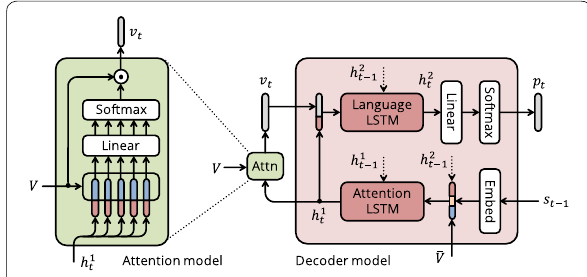
Fig. 5 Details of the attention module and the decoder module of UpDpwn model